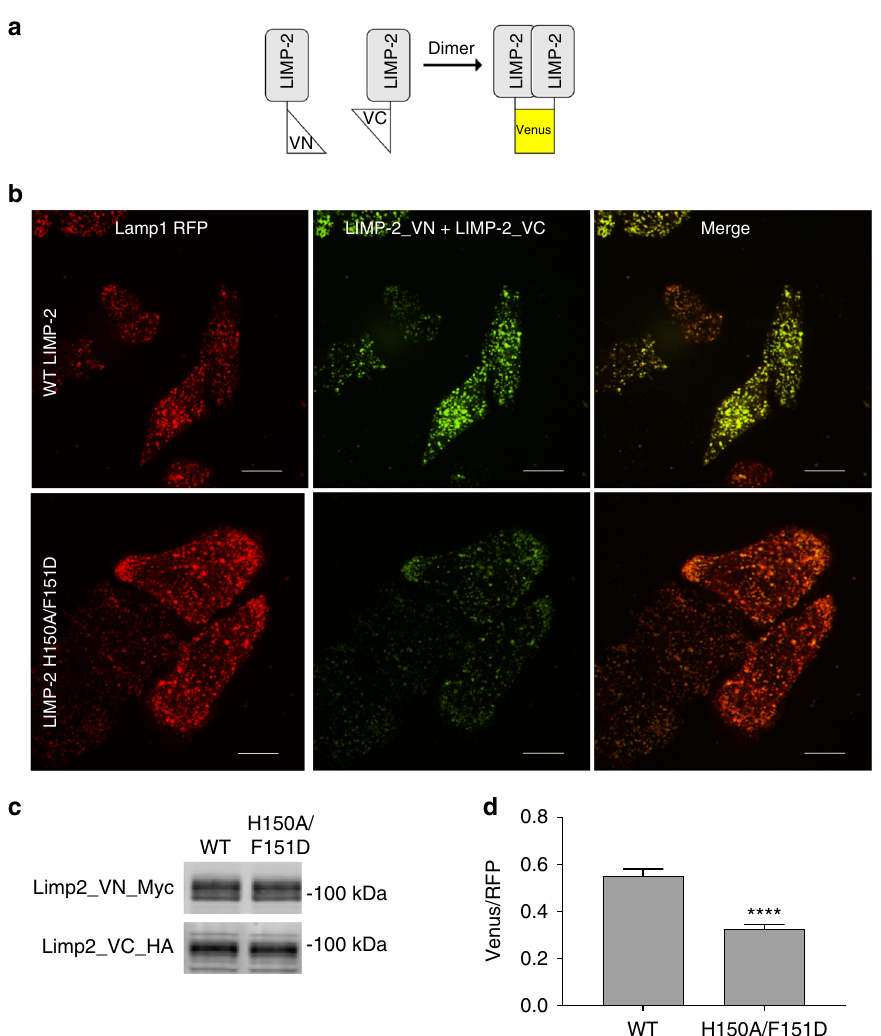
Fig. 4 Detection of LIMP-2 dimer in live cells using bimolecular fl uorescence complementation method. a Schematic illustration of constructs designed for bimolecular fl uorescence complementation in examining dimerization of LIMP-2. b High-resolution confocal images of Hela cells expressing LIMP-2 (WT, top, or H150A/F151D, bottom) fused to the N-terminal and C-terminal fragments of Venus fl uorescent protein along with Lamp1-RFP co-transfected as a lysosome colocalization marker. c Western blot showing expression levels of the LIMP-2 WT and H150A/F151D variants using anti-myc and anti-HA antibodies. d Quanti fi cation of the ratio of mean Venus fl uorescence intensity relative to ER-localized mCherry for cells transfected with LIMP-2 (WT and H150A/F151D) fused to the N-terminal and C-terminal fragments of Venus fl uorescent protein fl uorescence. Data is expressed as mean ± SEM, ~60 cells each experiment, n = 3, **** P < 0.0001, t test. Scale bar 20 µ